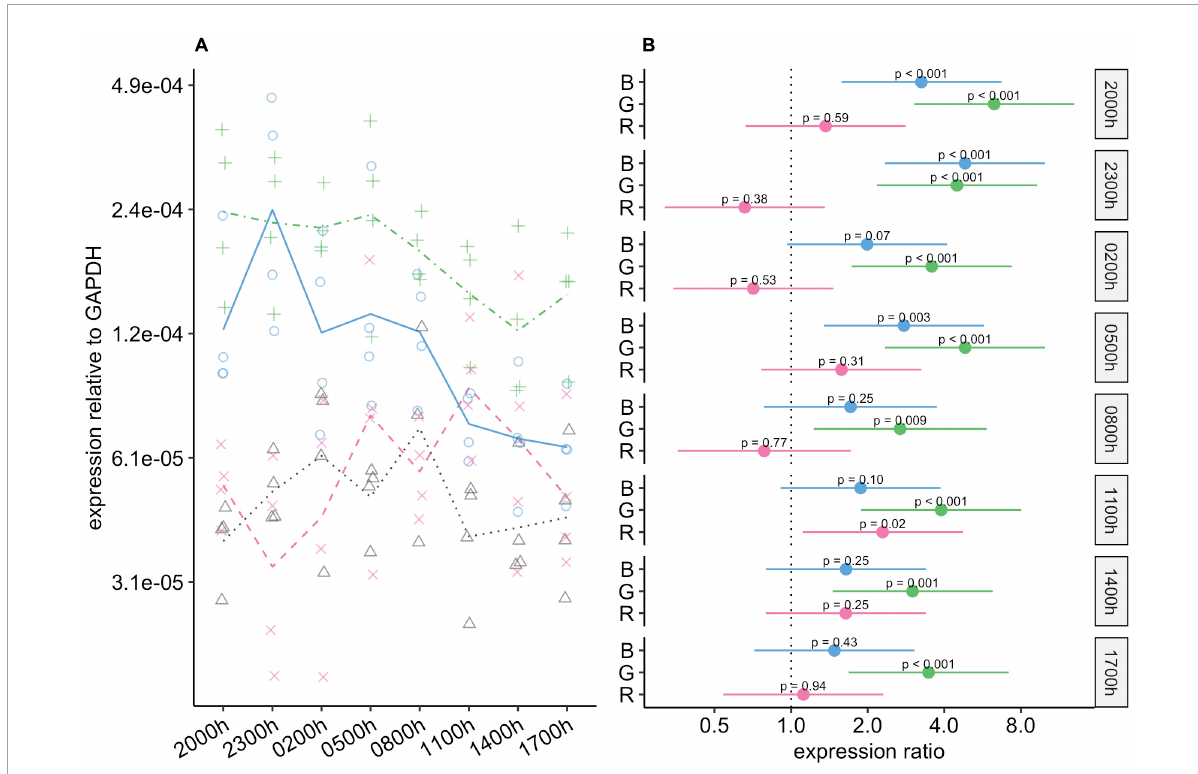
FIGURE7 Effect of monochromatic light exposure on Birc5 mRNA expression in the retinas of Wistar rats. Experimental details were the same as in Figure 1 . P -values and 95% confidence intervals were calculated with Dunnett’s test. Note that logarithmic scales are used. (A) Points show gene expression levels in individual rats; lines connect mean values in each group. To facilitate viewing by color-blind readers, different points and line types were used: control group, dotted line ( •• ) and triangles; red-light group, dashed line (– –) and x-marks; green-light group, dot-dash line ( • –) and crosses; blue-light group, solid line and circles. (B) Points show differences between group means; error bars show the 95% confidence interval for each difference. Abbreviations indicate which group is being compared to the control group: B, blue-light group; G, green-light group; R, red-light